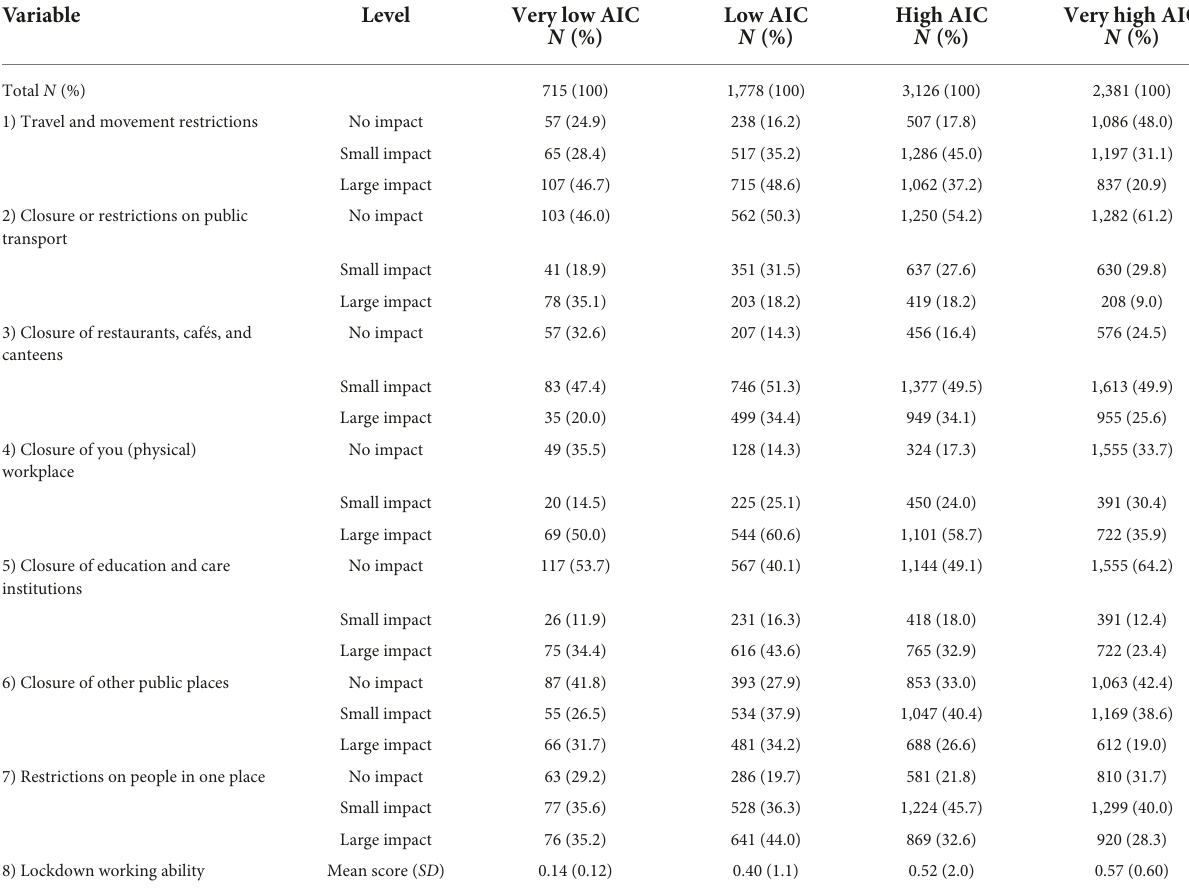
TABLE 4 Description of the AIC groups based on local and national COVID-19 restrictions’ impact on households and lockdown working ability: weighted data analysis. Variable Level Very low AIC